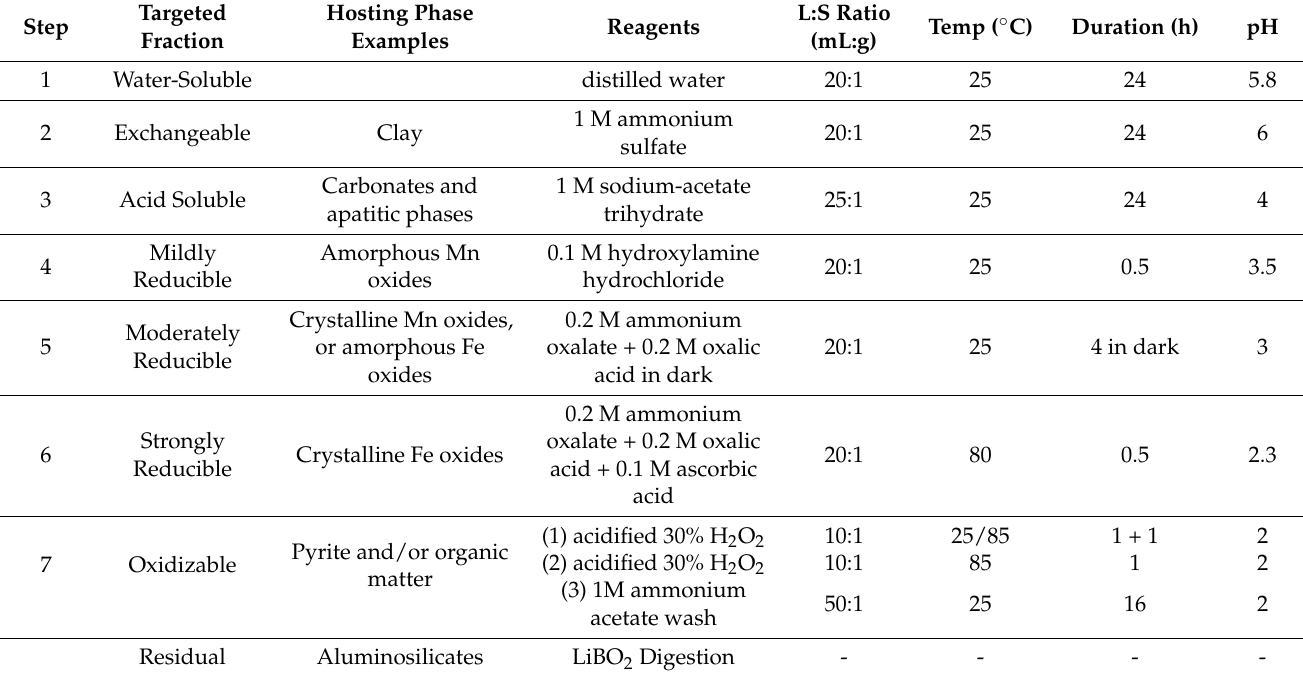
Table 2. Seven-step sequential extraction